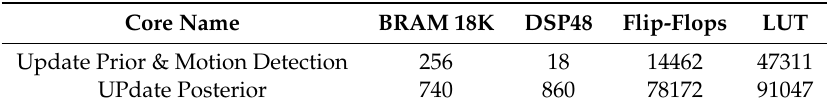
Table 4. FPGA resource